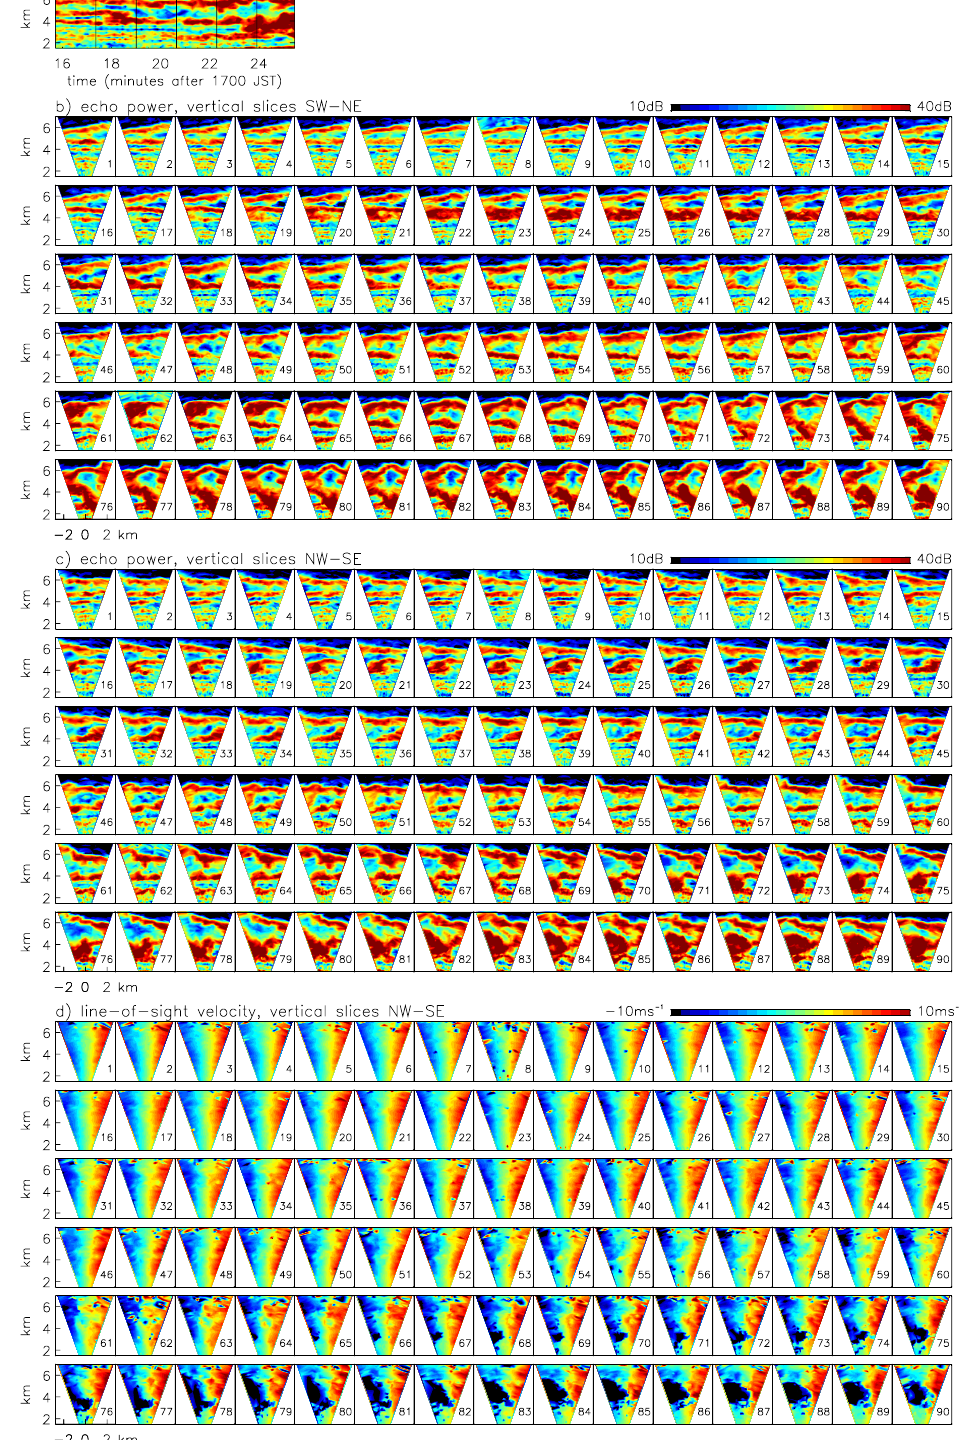
Fig. 11. (a) Height-time plot of vertical-beam echo power on 16 July 2002. (b)–(d) vertical slices of (b) echo power in SW–NE azimuth (c) echo power in NW–SE azimuth and (d) line-of-sight velocity in NW–SE azimuth, numbered 1–90, for same time and height as (a). Vertical and horizontal axes are 5.5km and time step 6.55s. Large downward motion in plots 70–90 is caused by precipitation. Vertical lines in (a) show edges of rows in (b), (c) and